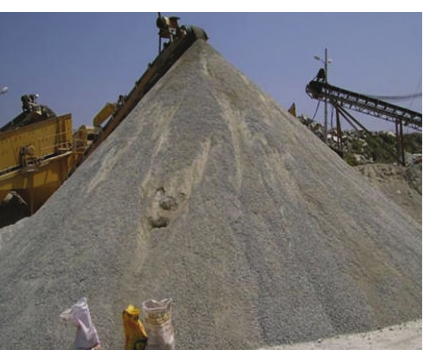
Figure 1: Fly ash sample.